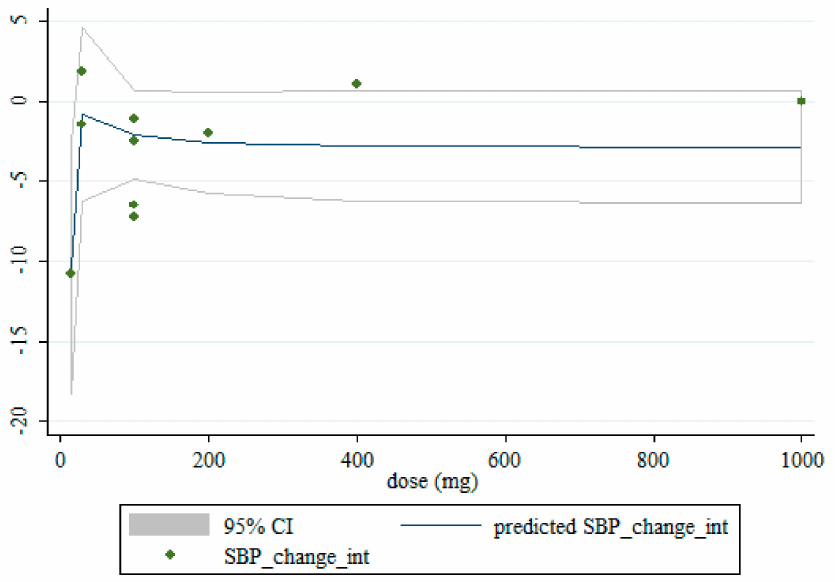
Figure 4. Non-linear dose-response relationships between saffron supplementation and absolute mean differences. Dose-response relationships between saffron dosage and absolute mean differences in SBP.